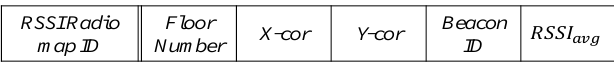
Figure 3. Data structure for the beacon fingerprint map.